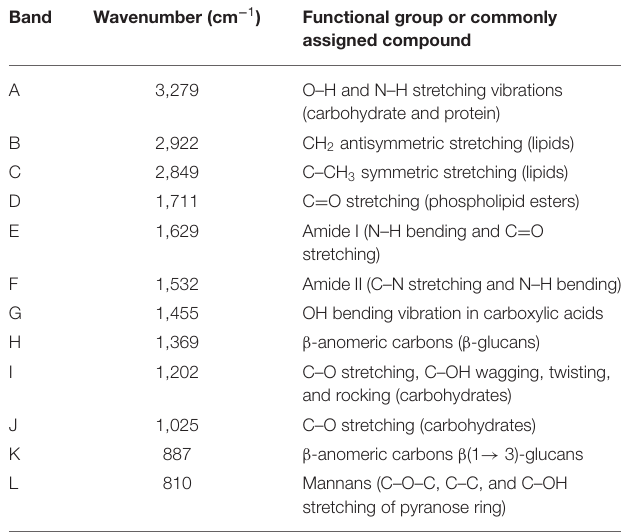
TABLE 2 | Band assignments of the primary vibrational frequencies in the yeast cell wall fraction